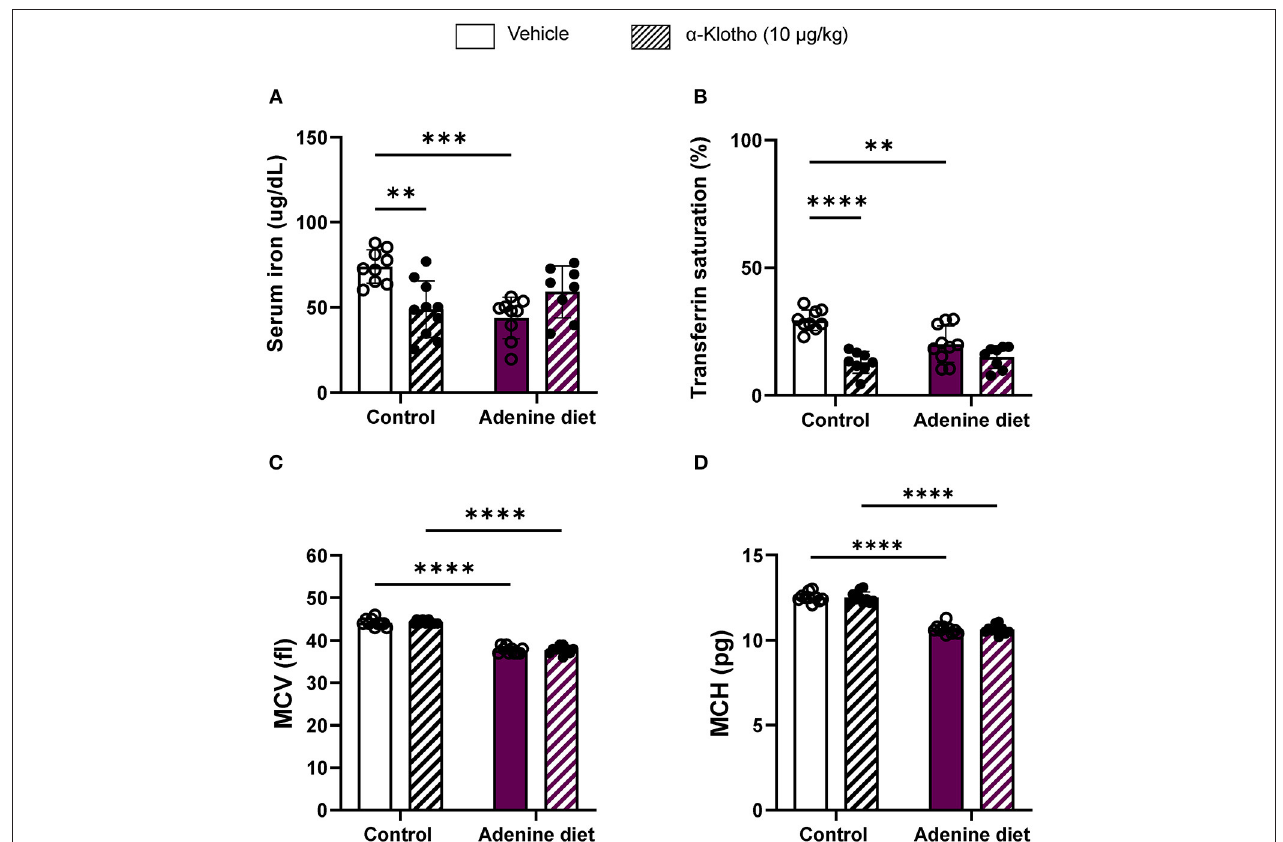
FIGURE 5 | Iron homeostasis in response to CKD and klotho supplementation. C57BL/6J male mice were fed control diet or 0.2% adenine diet. After 8 weeks, mice in each group were further divided into 2 groups and were injected with either saline or mouse recombinant Klotho protein (10 µ g/kg) 24h prior to sacrifice. Serum samples were obtained and iron concentration was determined by colorimetric method. (A) Serum iron, (B) transferrin saturation. Whole blood was collected separately at sacrifice and quantified for MCV and MCH using Hematology analyzer. (C) Mean corpuscular volume (MCV), (D) mean corpuscular hemoglobin (MCH). Data are represented as mean ± SD ( n = 8–10 per group). ** P < 0.01, *** P < 0.001, **** P < 0.0001 compared to Control.